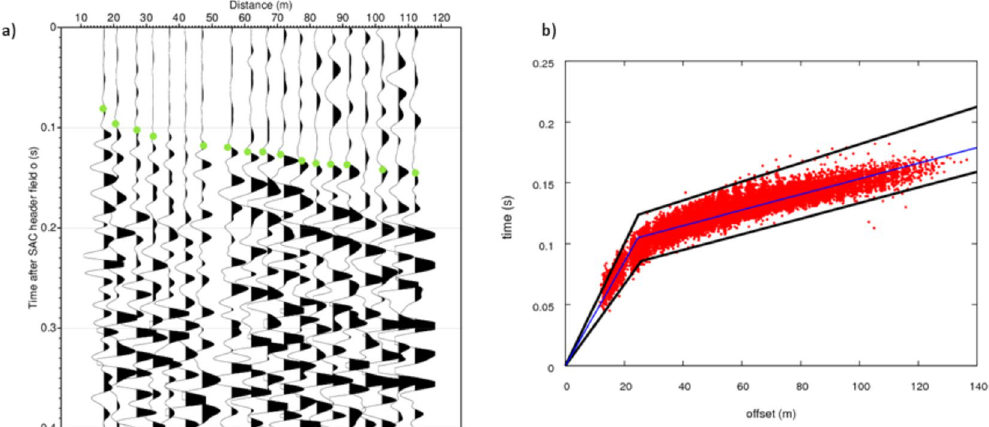
Figure 2. Data and travel-time-vs-distance plot. ( a ) Example of seismic section in common shot gather. The processed traces concerns the shot 194 recorded at stations 25 to 48. The green dots represents picks of first arrival P phases obtained with PROMAX and manually revised. ( b ) Plot of travel-time-vs-distance (red dots). The black lines are the limit imposed for the construction of 1D initial velocity models. Blue line is the 1D initial model selected for the